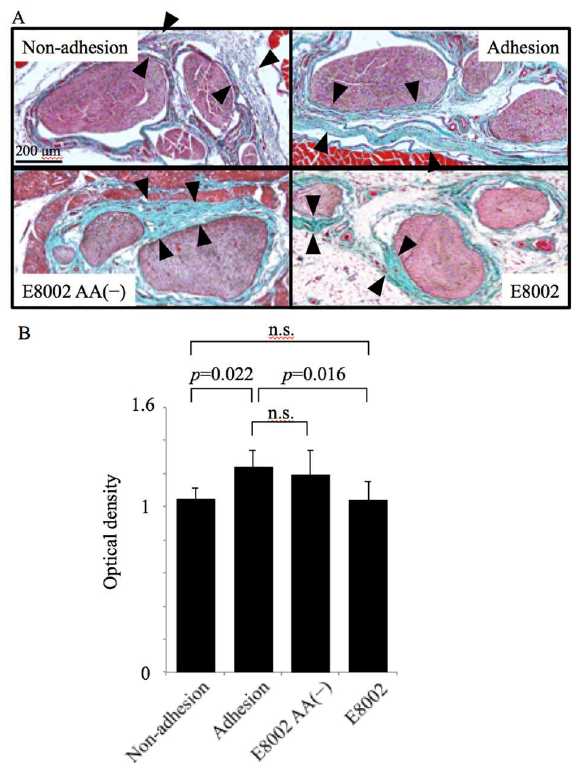
Figure 4. Effect of the E8002 membrane on microscopic appearance of peripheral nerve adhesions at 6 weeks post-surgery. ( A ) Representative photomicrographs of the sciatic nerve and neural bed stained with aldehyde fuchsin Masson–Goldner staining (scale bar, 200 µm). Pink-stained nerve tissue located in the center is surrounded by connective tissue (light blue/green area indicated by black arrowheads). In the E8002 group, there was thin and loose connective tissue around the nerve, with space (no staining) surrounding the connective tissue. This space was considered to be a trace of E8002 absorption. ( B ) Quantitative analysis of the optical density of the Masson–Goldner staining ( n = 7 adhesion sites or related areas per group). Values are mean ± SE; n.s., non-significant determined by one-way analysis of variance followed by the Bonferroni–Dunn correction.